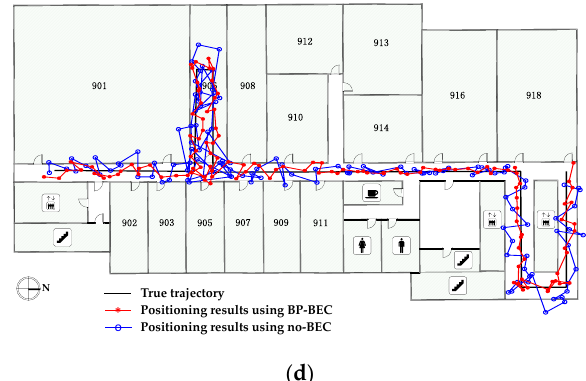
Figure 17. The real trajectories in Test bed 2 and the positioning results comparison between the BP-BEC and the no-BECalgorithms: ( a ) the real trajectory 1 in Test bed 2; ( b ) the real trajectory 2 in Test bed 2; ( c ) the positioning results comparison along trajectory 1; ( d ) the positioning results comparison along trajectory 2.